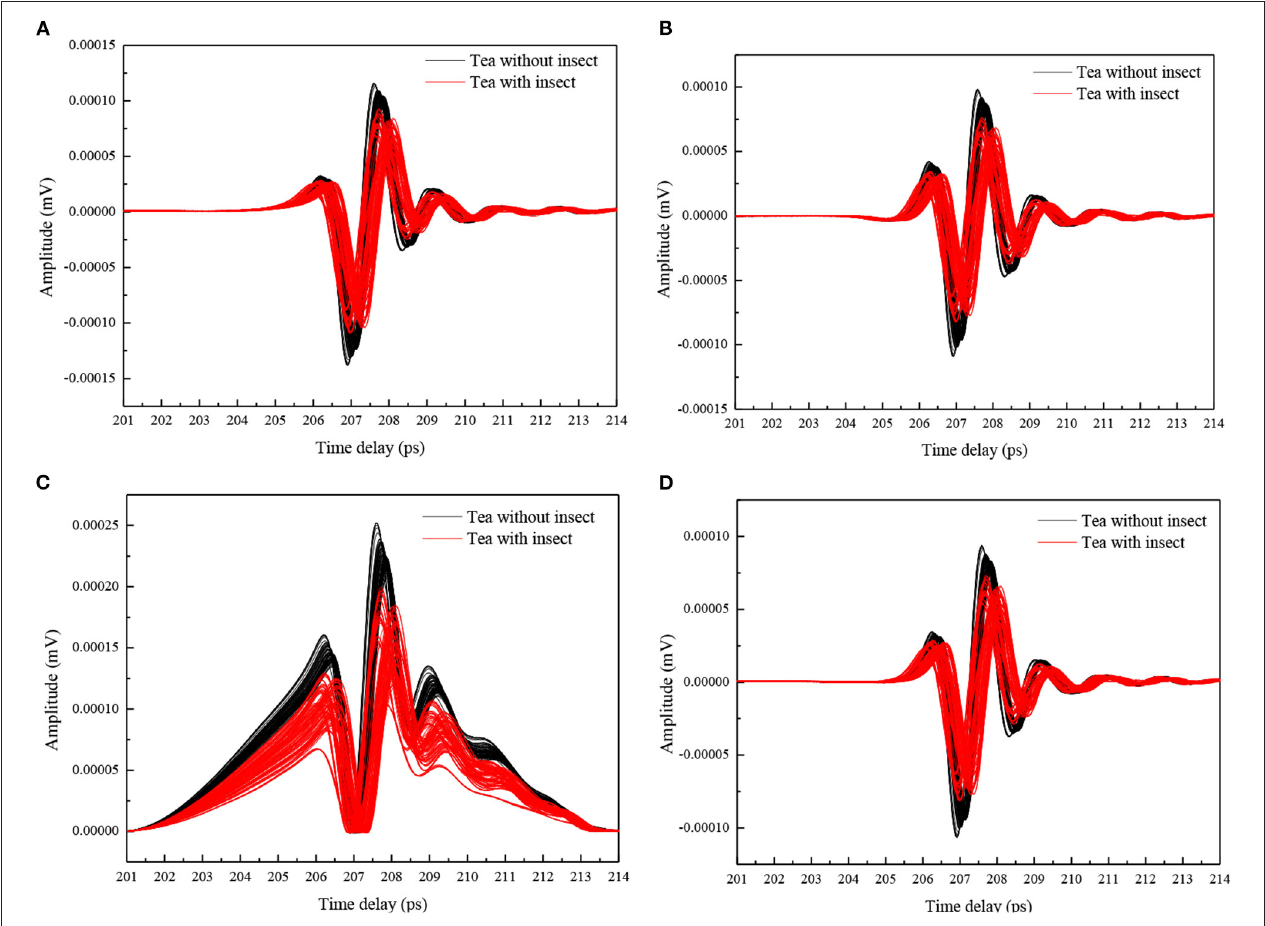
FIGURE 4 | Raw spectra (A) and the spectra after baseline correction with AsLS (B) , AirPLS (C) , and BEADS (D) .